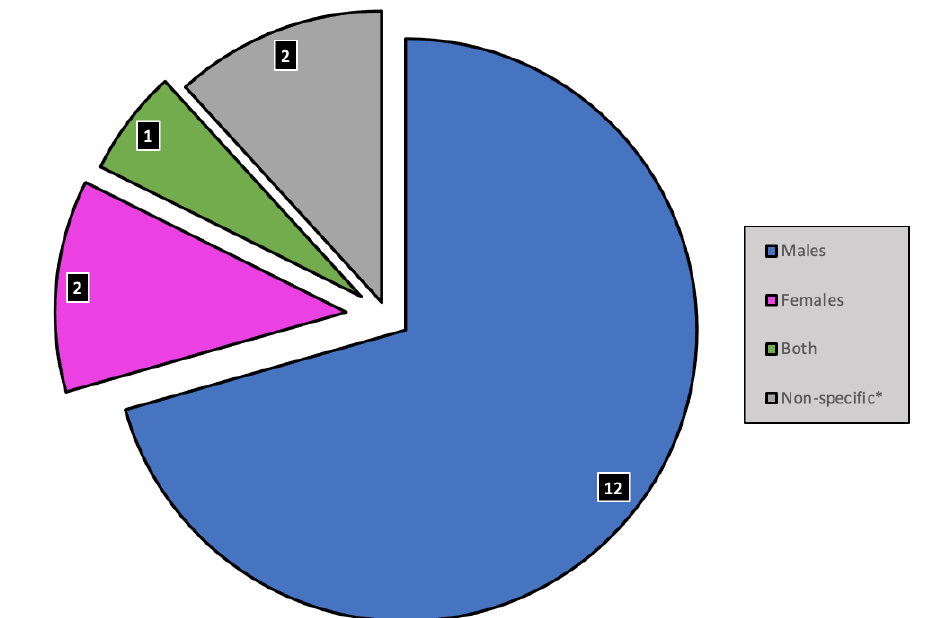
Figure 3. Sex distribution of study population/focus. * Studies that did not refer to sex explicitly within the study